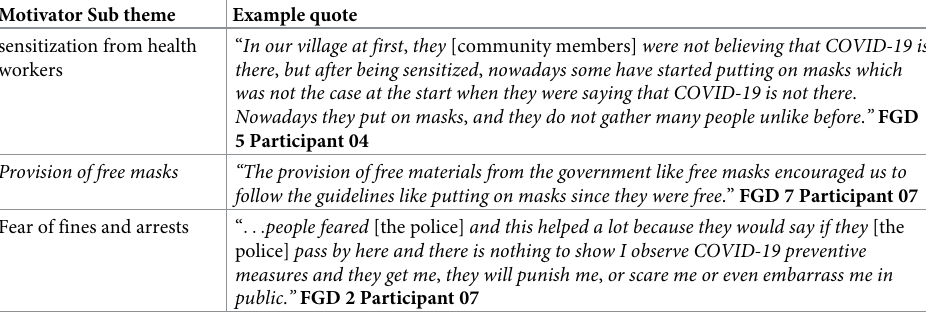
Table 3. Qualitative findings pertaining to motivators of mask